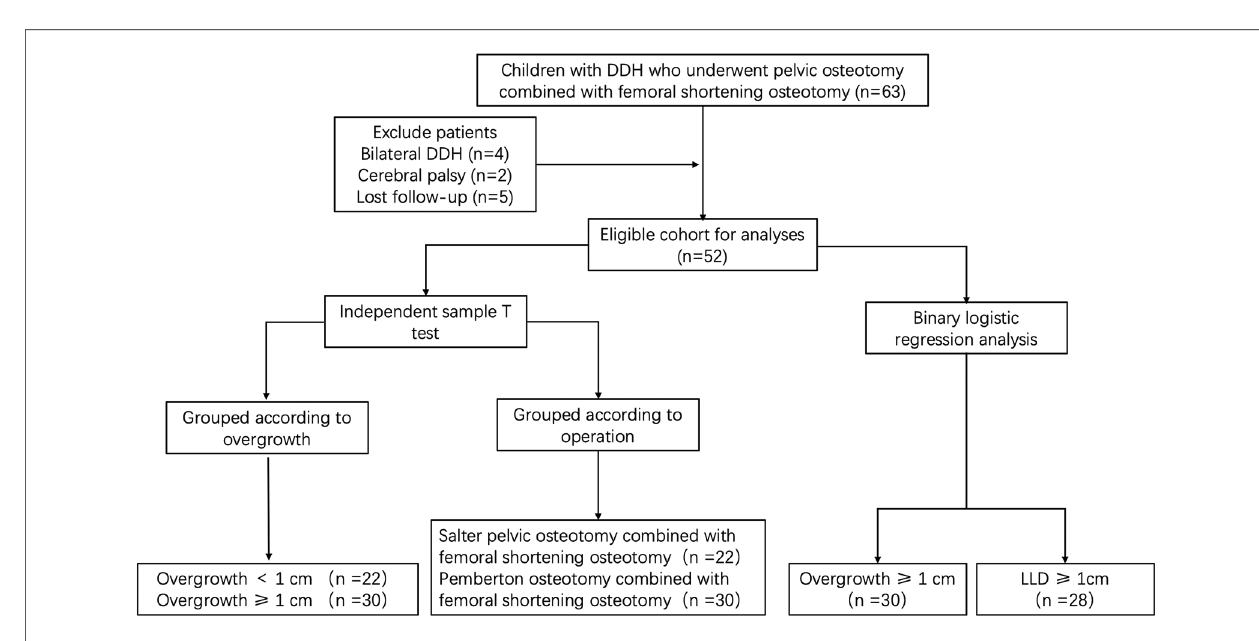
FIGURE 3 A fl owchart of patient ’ s selection and study design. DDH: developmental dysplasia of the hip; LLD: limb length